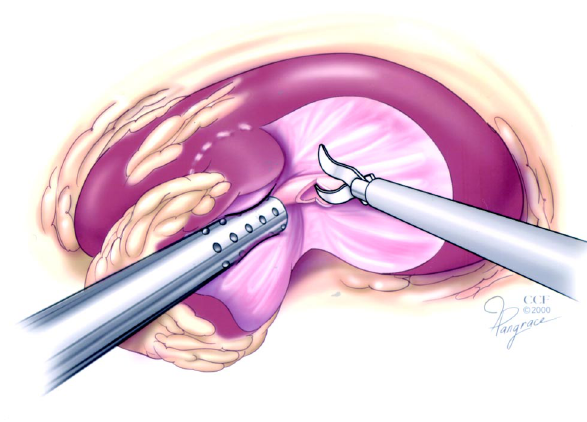
Figure 2 – Tumor excision. Calyx adjacent to tumor is being deliberately entered sharply with shears to maintain a margin of healthy renal parenchyma. Adapted from reference 10. (Reprinted with the permission of the Cleveland Clinic